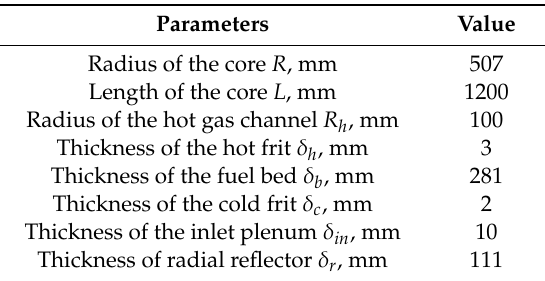
Table 2. Main geometrical parameters of the